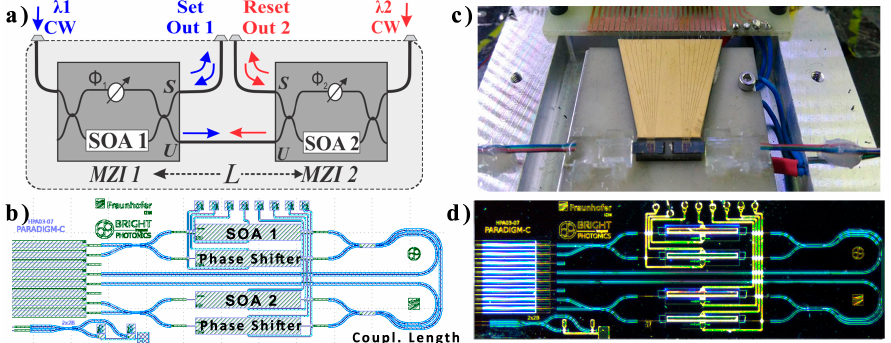
Figure 2. ( a ) All-optical Flip-Flop architecture and operation; ( b ) Mask-layout of the fabricated monolithic InP Flip-Flop; ( c ) Image of the packaged Flip-Flop device with electrical/optical connections and TEC element; and ( d ) Microscope image of the fabricated Flip-Flop